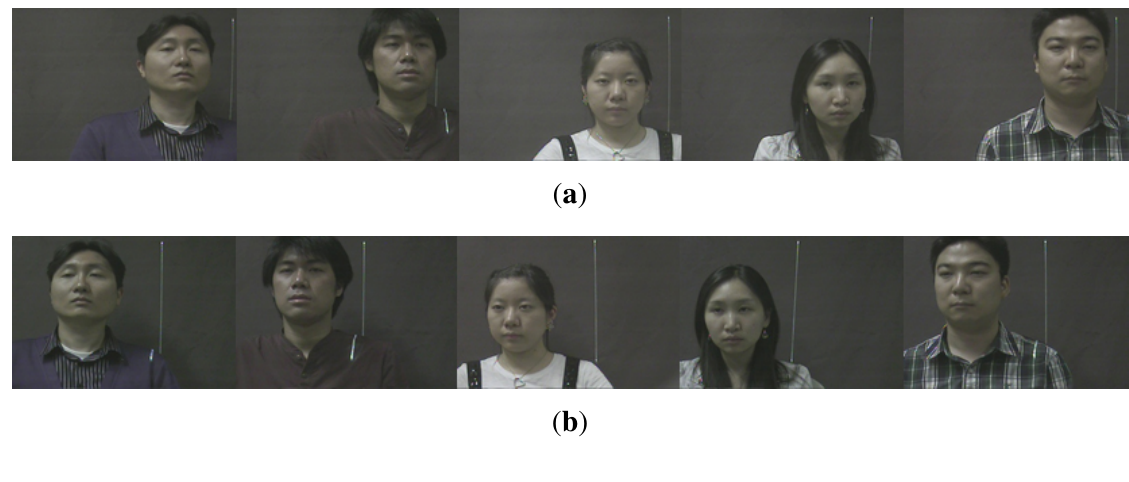
Figure 17. Sample images from the database: ( a ) face images from the left camera; and ( b ) face images from the right camera.